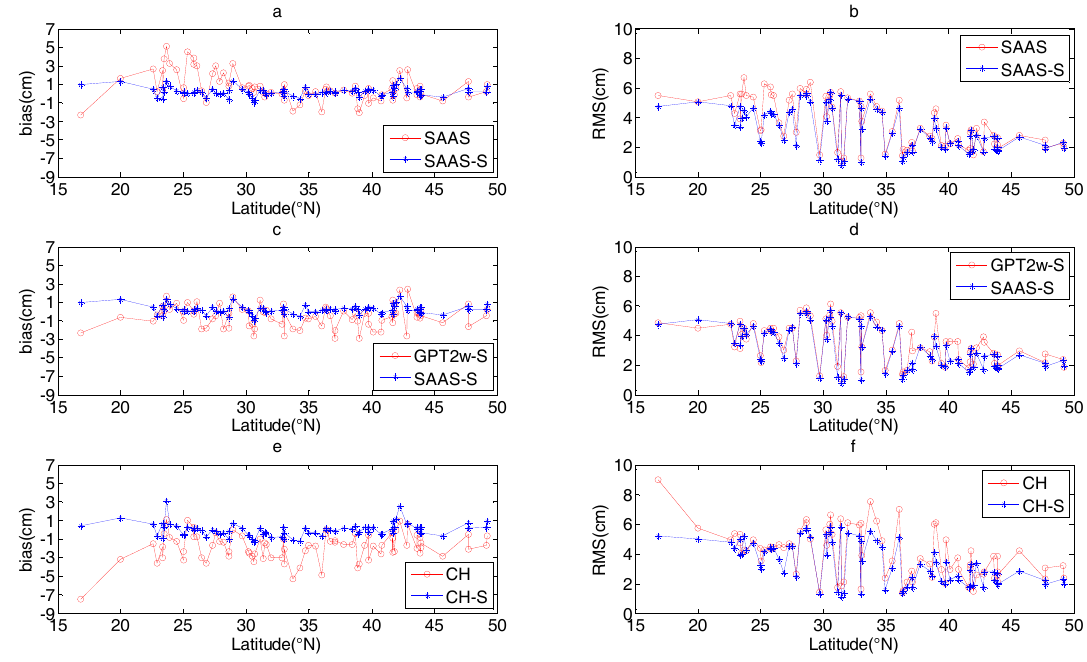
Figure 3. Comparison of the accuracy of the three groups of tropospheric models in different regions. The detailed models of each subgraph are as follows: ( a ) and ( b ) include the SAAS and SAAS_S models; ( c ) and ( d ) include the GPT2w_S and SAAS_S models; ( e ) and ( f ) include the CH and CH_S models.